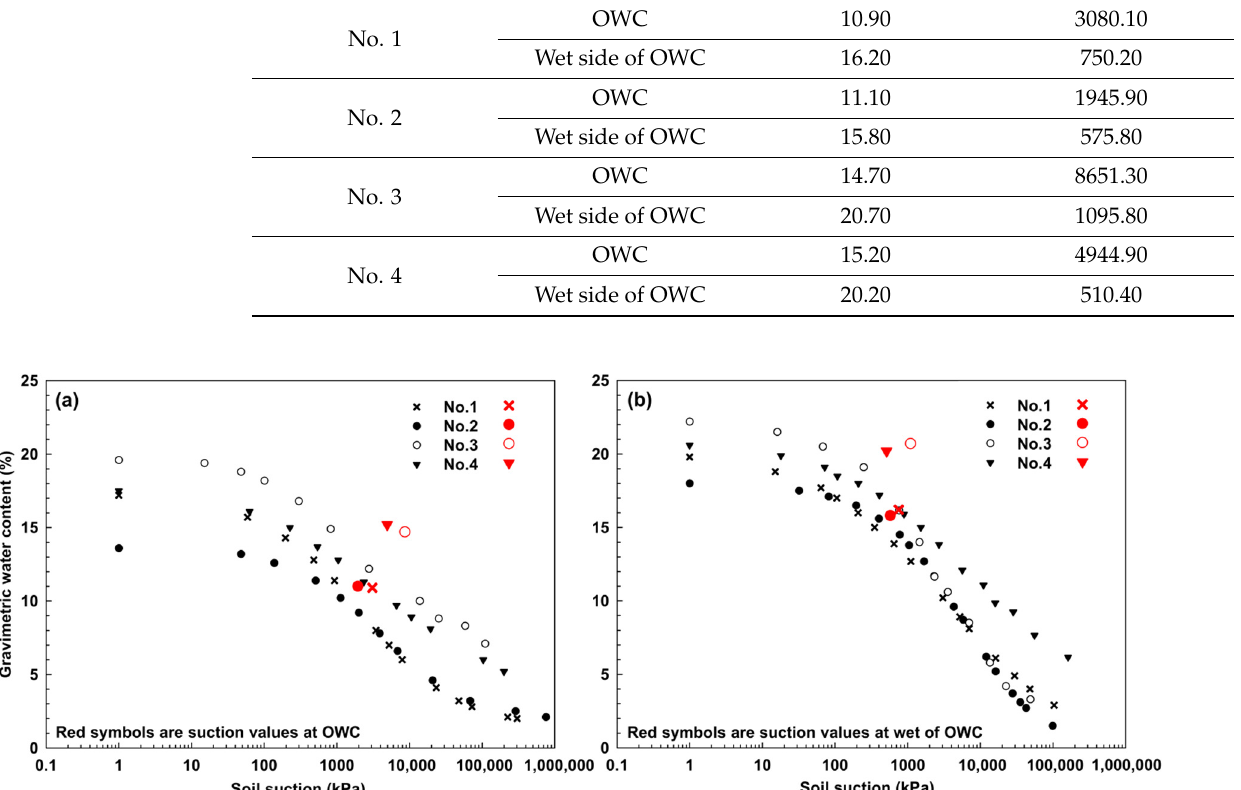
Table 3. Matric suction values at compacting water content for compacted samples.